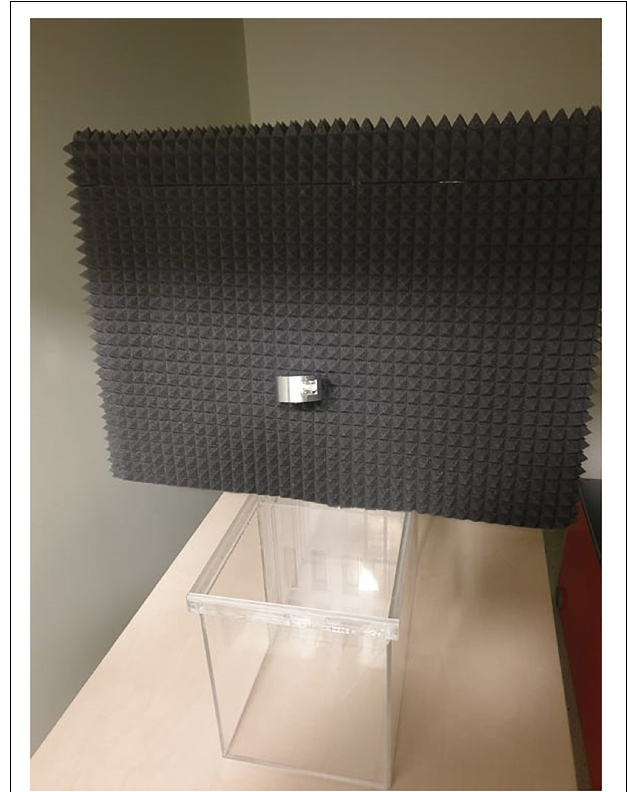
FIGURE 4 | The photograph of the VOC-NCE located in the behavioral recording room (the frontal view). For clarity, cables have been unplugged from the microphones, and the covering grid was removed.